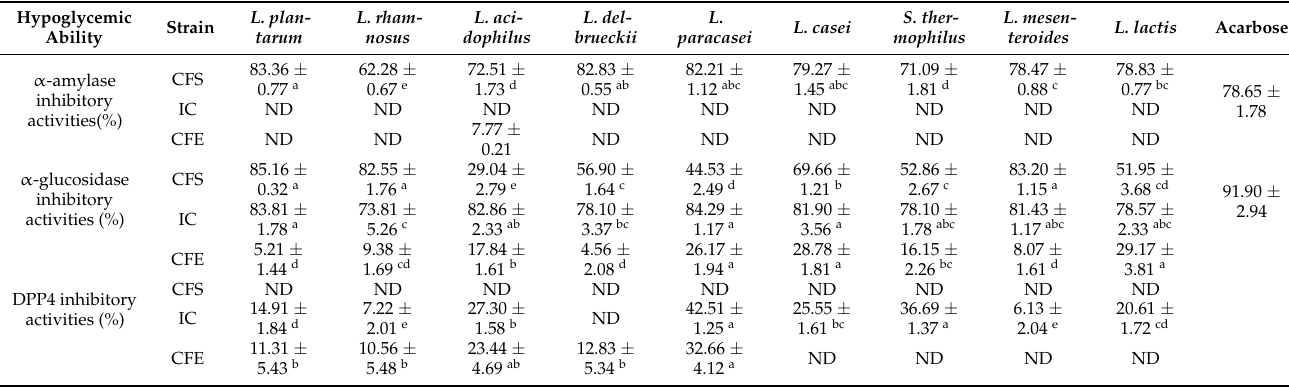
Table 1. Hypoglycemic ability of